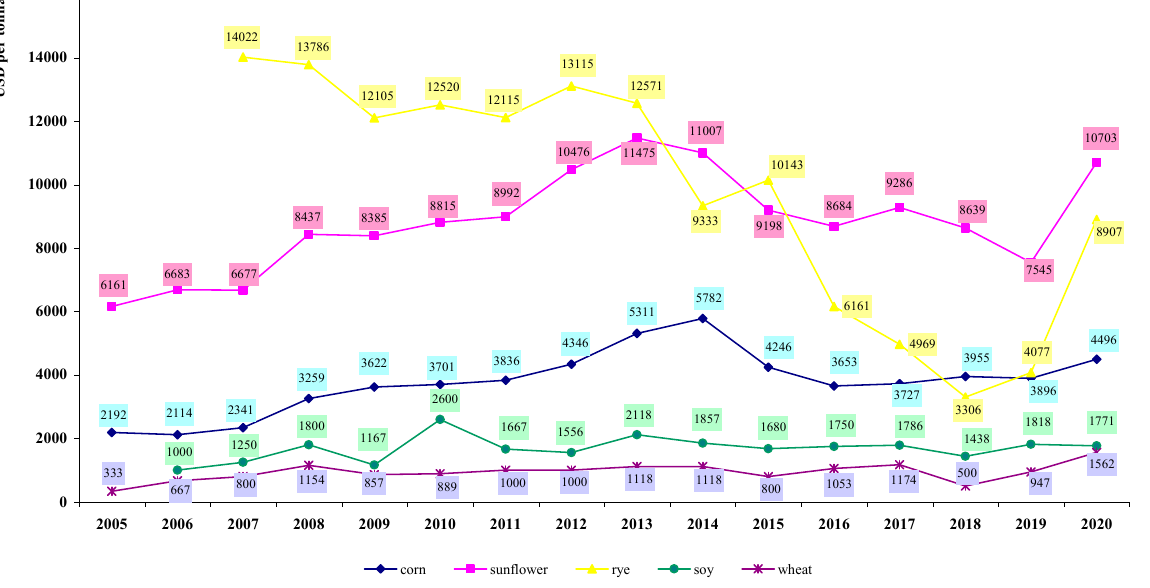
Figure 5. Dynamics of prices for imported seeds of crops and oilseeds, USD without VAT. Source: State Statistics Service of Ukraine.